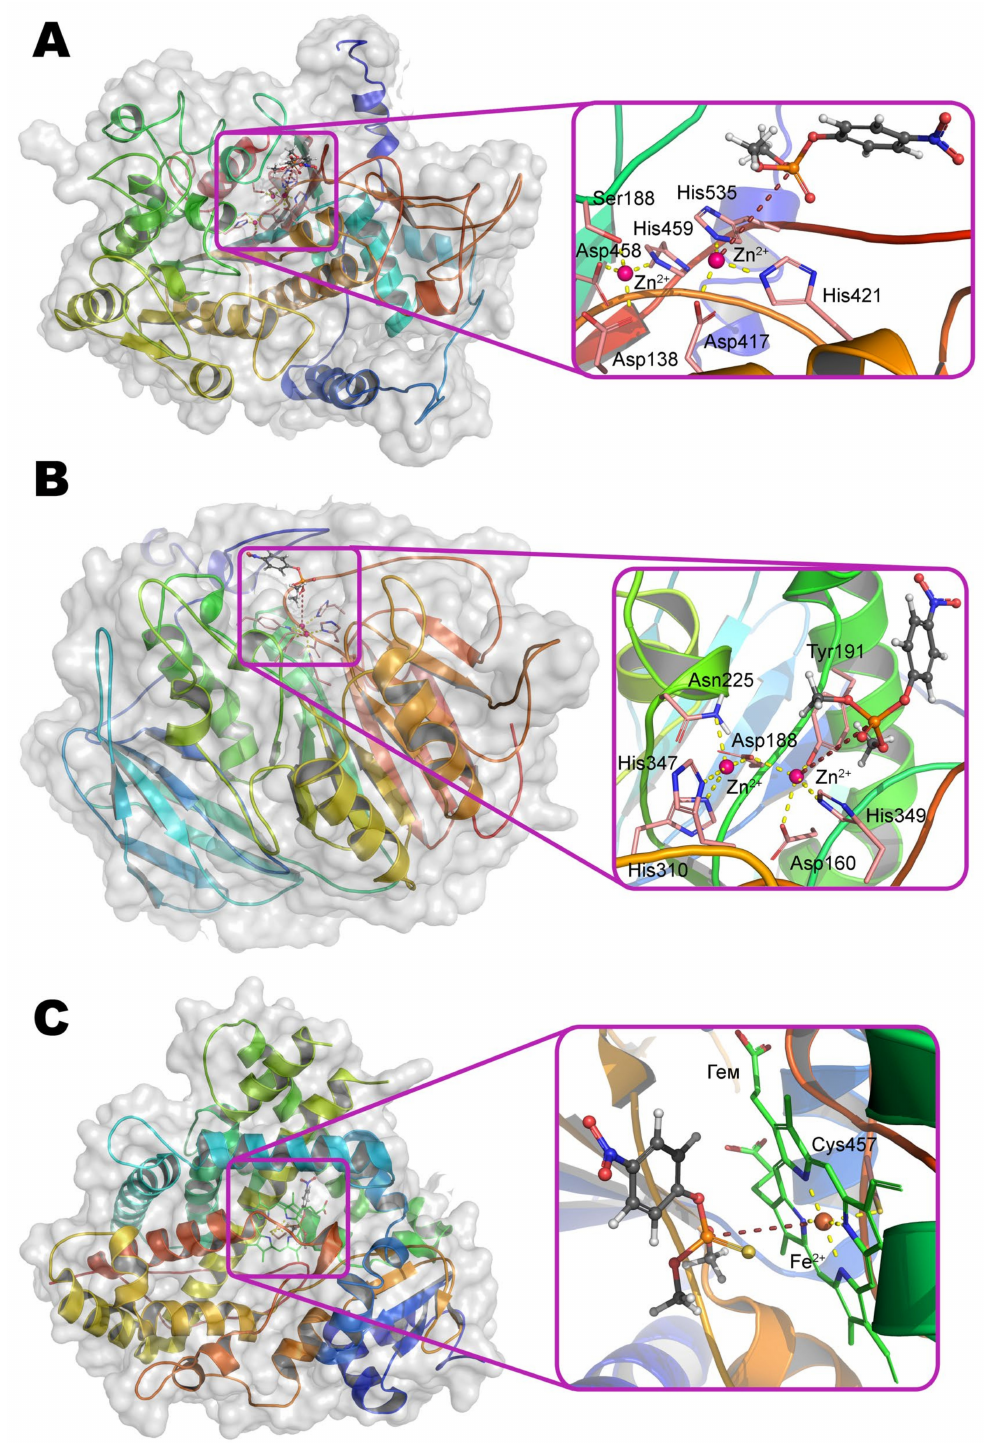
Figure 12. The structure of ALP monomer ( A ), ACP monomer ( B ), and CYP1A1 monomer ( C ) according to data (UniProt A0A2W1BMI5, UniProt Q9MB07, and PDB 4I8V, respectively). The entrance to the active centers of the enzymes is framed, and their structures are shown in detail within insets. The structures of ALP and ACP were predicted with I-TASSER server (http://zhanglab.ccmb.med.umich.edu/I-TASSER/) as described in [64]; after that the residues of the active centers were aligned with known structural homologues (PDB 1K7H and 1KBP, respectively), and coordinates of metal ions were determined and used further. The binding of the substrate methyl paraoxon ( A , B ) and methyl parathion ( C ) was determined as previously. The coordination bonds of metal ions with amino acid residues in active centers, as well as with labile groups of the substrate are shown by a dashed